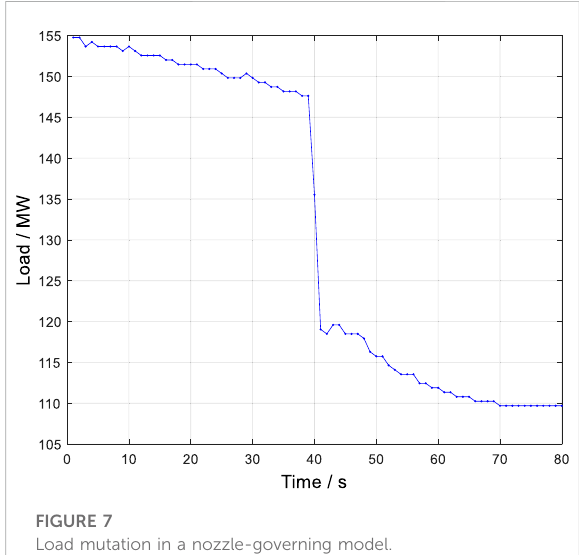
FIGURE 7 Load mutation in a nozzle-governing